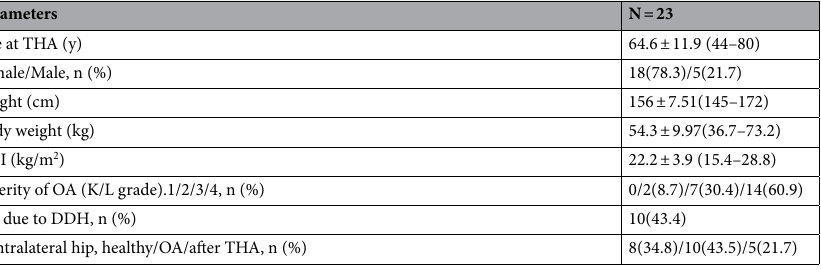
Table 1. Characteristics of patients. Continuous values are expressed as mean ± standard deviation (range). THA, total hip arthroplasty; BMI, body mass index; OA, osteoarthritis; K/L, kellgren-Lawrence; DDH, developmental dysplasia of the